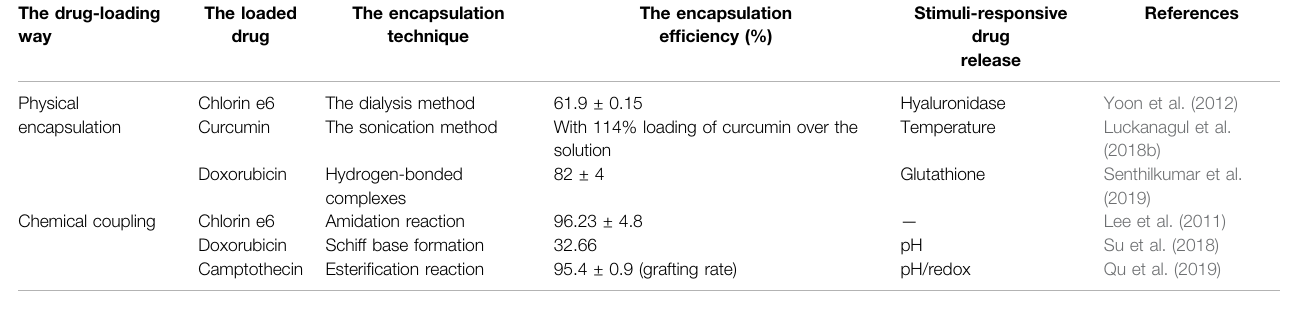
TABLE 2 | The drug-loading ways and relevant drug release behaviors of NG-DDS. The drug-loading way